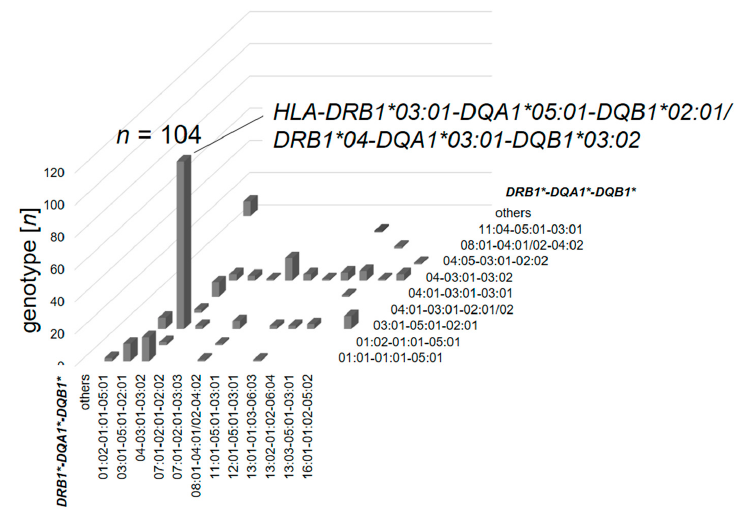
Figure 1. Number of observances of each haplotype combination from the total of the early-onset type 1 diabetes (T1D) cohort ( n = 233).